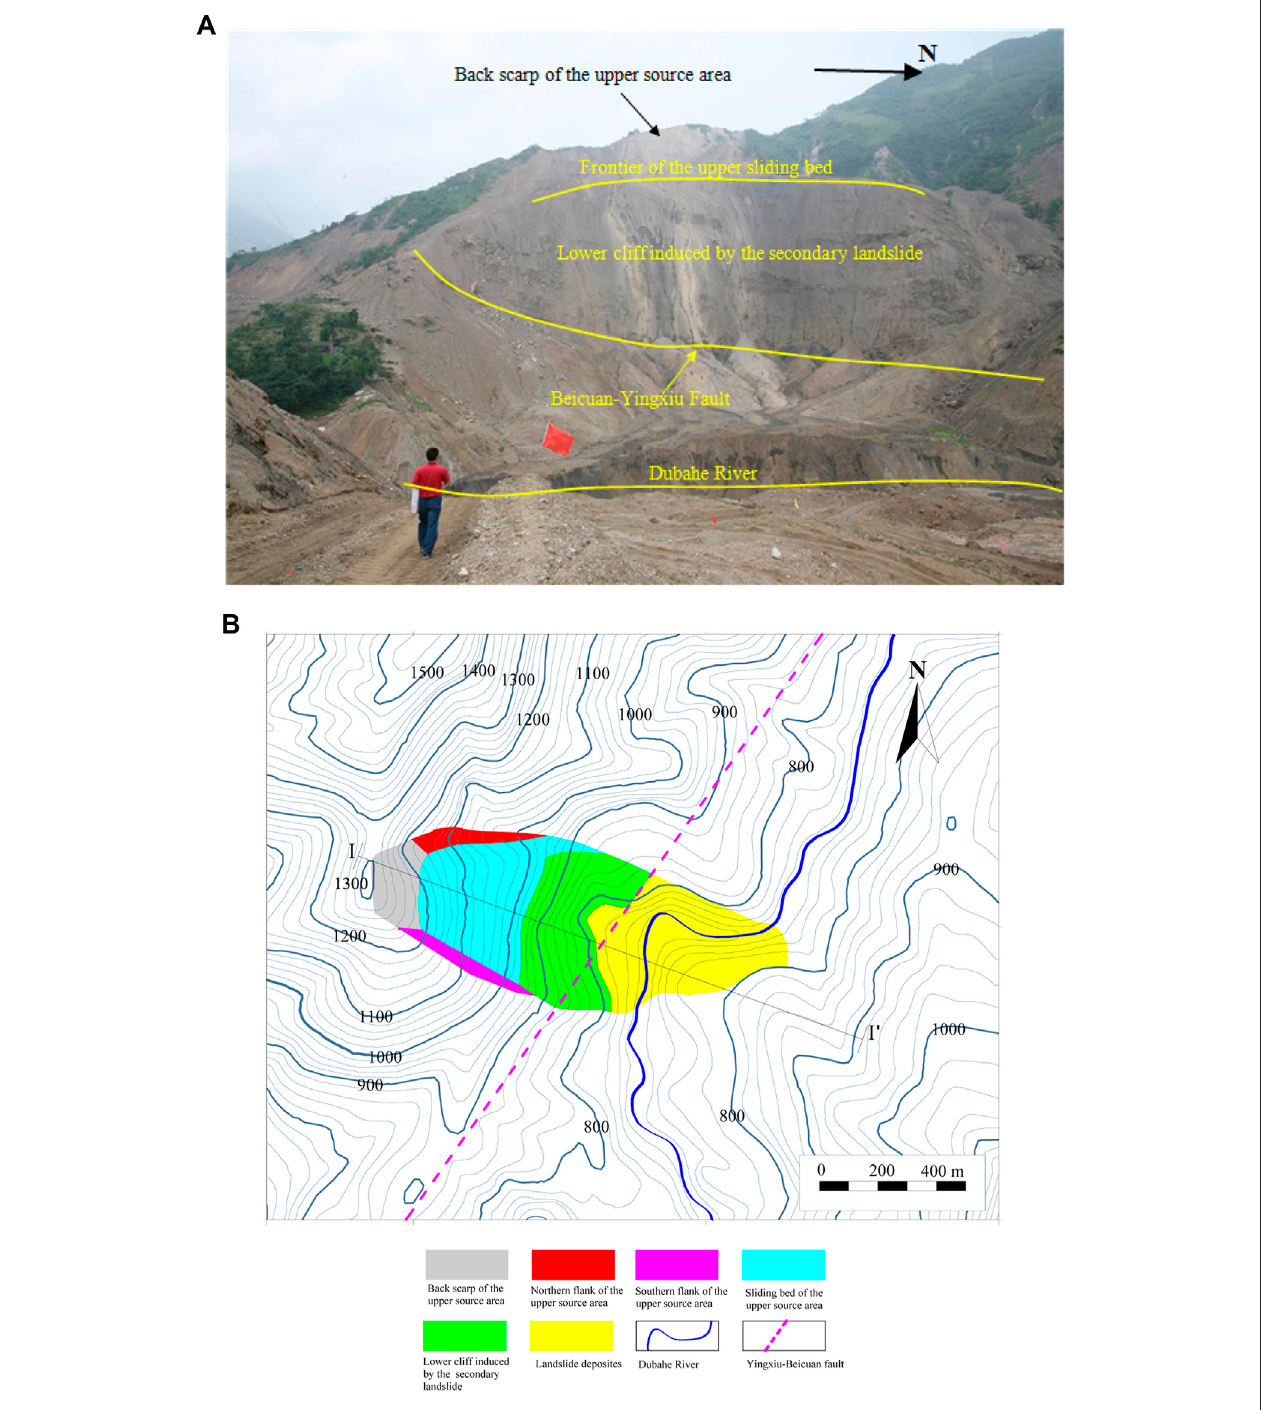
FIGURE 3 | (A) Photograph of Taihongcun coseismic landslide, which was taken on July 3, 2008 and the landslide dam had already been breached arti fi cially. (B) Plane view of the Taihongcun landslide. (C) Geological longitudinal section through the main slding direction I-I ′ for the Taihongcun landslide.